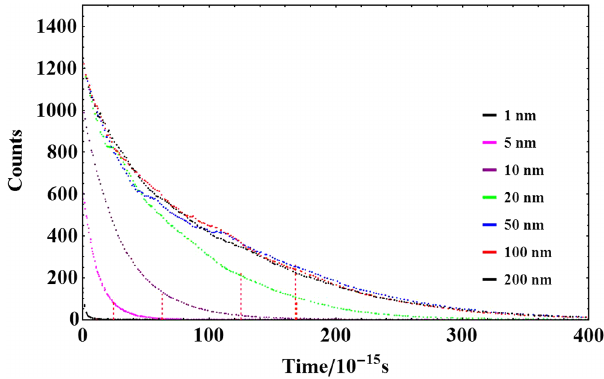
FIG. 12. Simulated temporal response of the K 2 CsSb cathode at room temperature with various thicknesses. The red dashed lines are the temporal response including 90% electrons.